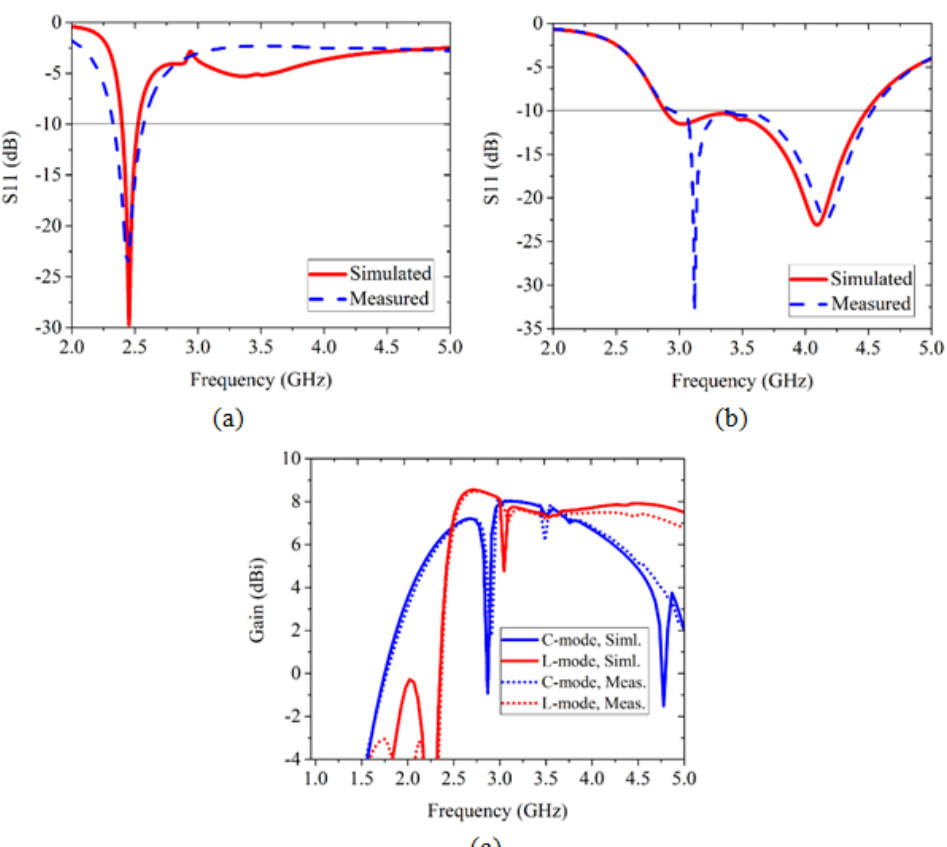
Figure 15. Simulated and measured S-parameters (S11, dB): ( a ) C-mode, ( b ) L-mode, and ( c ) Gain, dBi in both operating modes at their desired operating